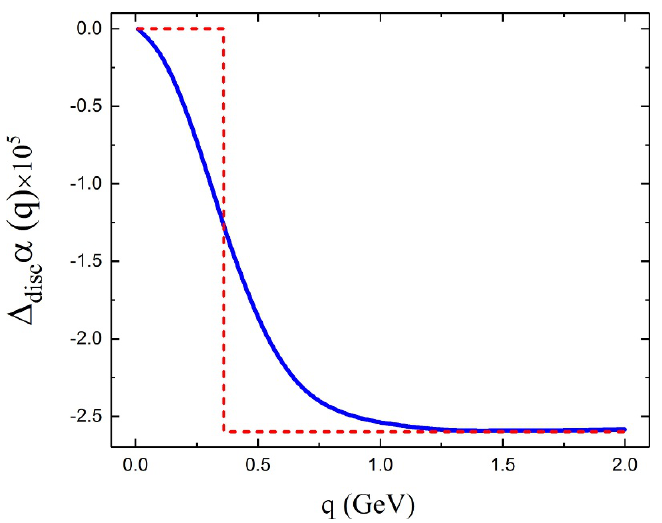
Figure 2 . Scale dependence of the singlet contribution to (cid:1) (cid:11) (solid line) and its step function approximation (dashed